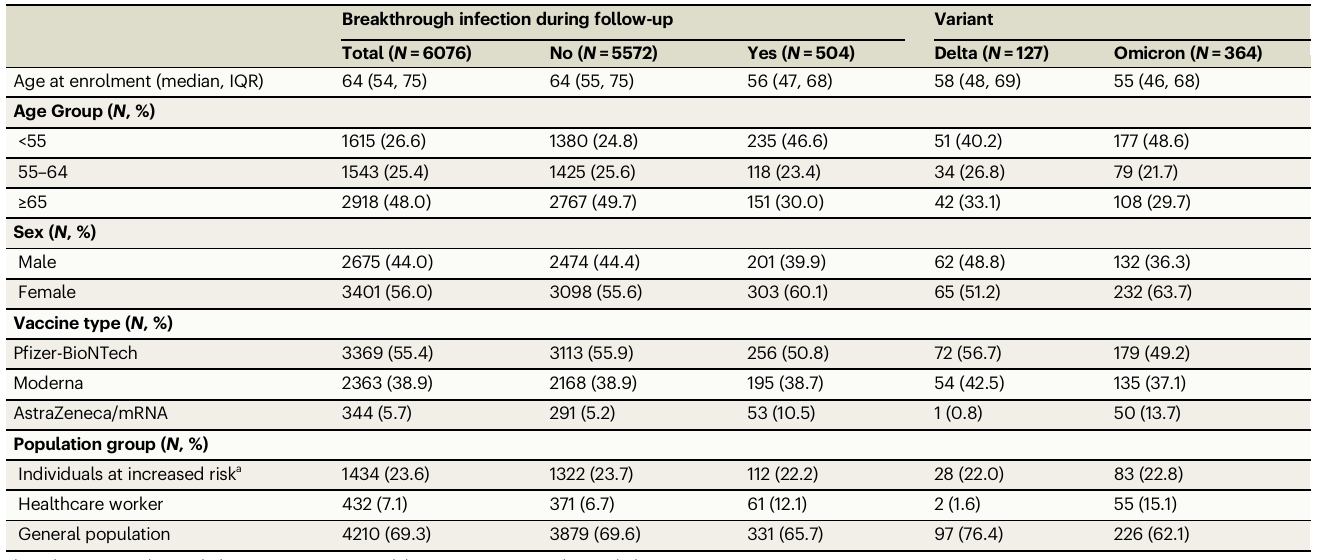
Table 1 | Participant demographics at baseline (14 days after second SARS-CoV-2 vaccination) Breakthrough infection during